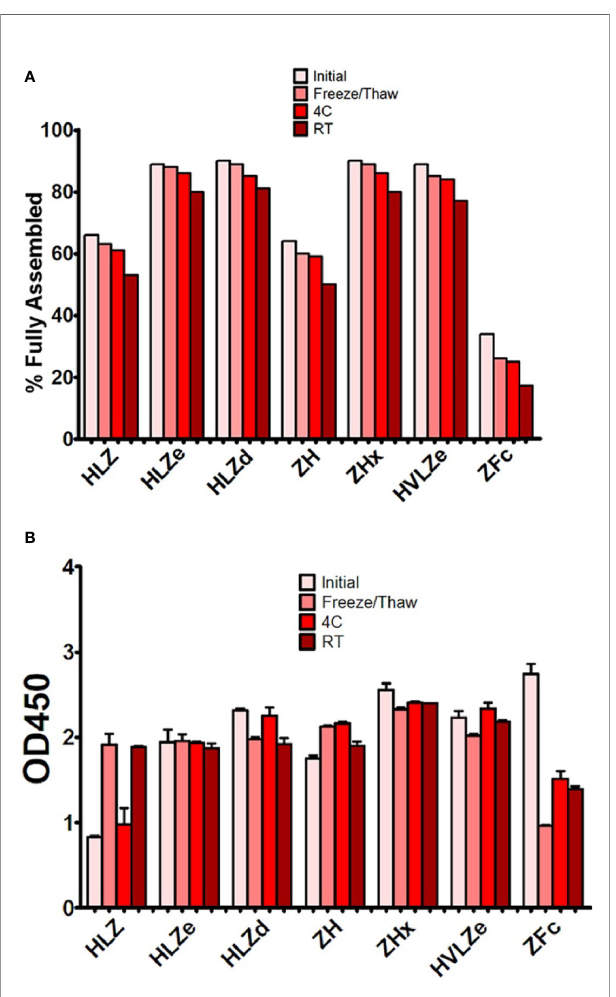
FIGURE 5 | Stability and C1q binding of puri fi ed IgG fusions. Samples of puri fi ed IgG fusions were frozen and thawed once after puri fi cation (initial), or additionally subjected to either additional fi ve freeze/thaw cycles, incubation for 2 weeks at 4°C, or incubation for 2 weeks at 23 ˚ C (A) . After each treatment, samples were separated on reducing and nonreducing SDS-PAGE gels, and the relative proportion of fully assembled product was analyzed using ImageJ software. The initial measurement re fl ects degradation which occurred during expression or puri fi cation, whereas the other measurements re fl ect degradation which occurred during each respective treatment (B) . Samples from each treatment were analyzed by C1q binding ELISA. Columns represent the mean OD 450 value ± standard error from three samples.